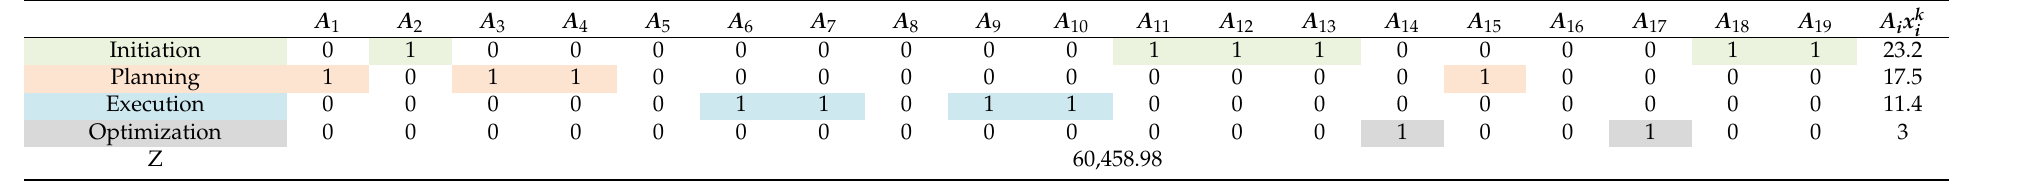
Table 5. Optimal objective function values and corresponding response